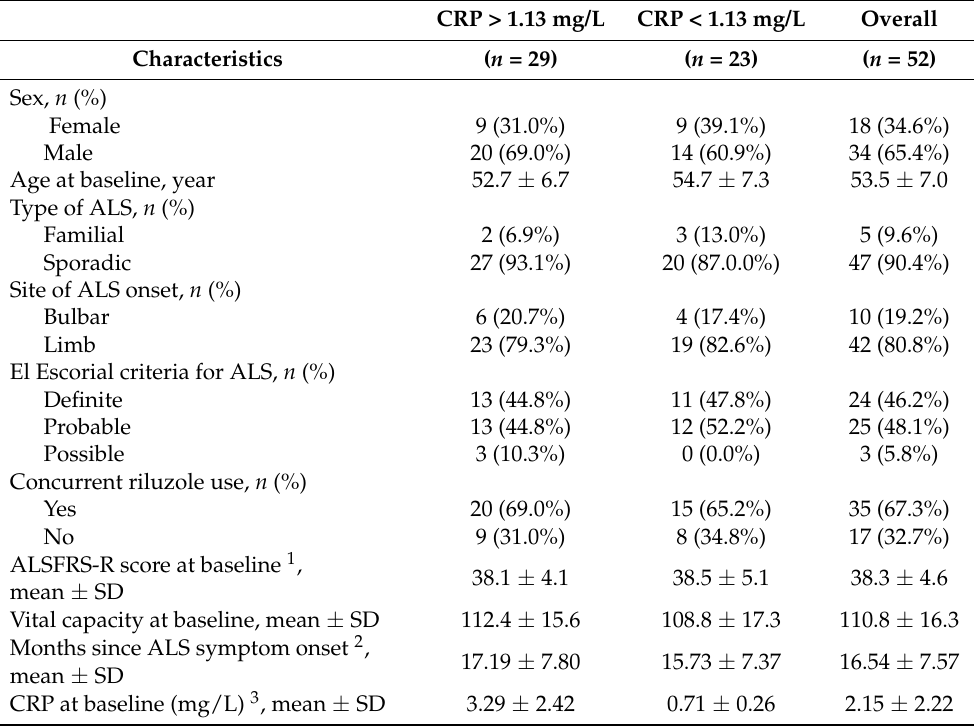
Table 1. Baseline demographics and characteristics of participants in groups of age between 40 and 65 years old with CRP below and above 1.13